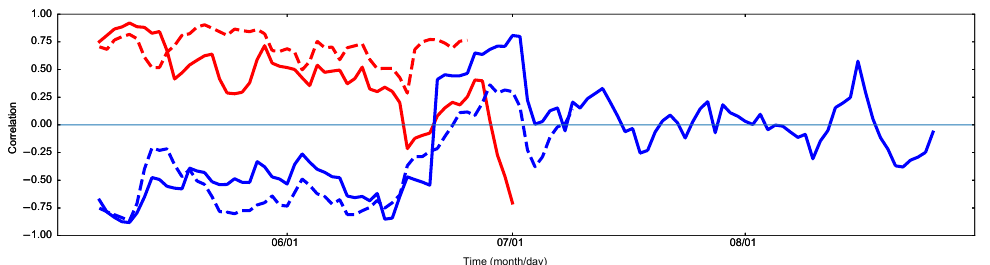
Figure 6. Moving correlations between the following variables. Red dashed line: total diurnal snowmelt and maximum daily water level at well 4; red solid line: maximum daily water level at well 4 and maximum water level in stream; blue dashed line: maximum daily transpiration and minimum daily water levels at well 4; blue solid line: maximum daily transpiration and minimum water level at stream. Well 4 was chosen because it contains the largest number of diurnals. Correlations for each day were performed using the points within a centered 16 day